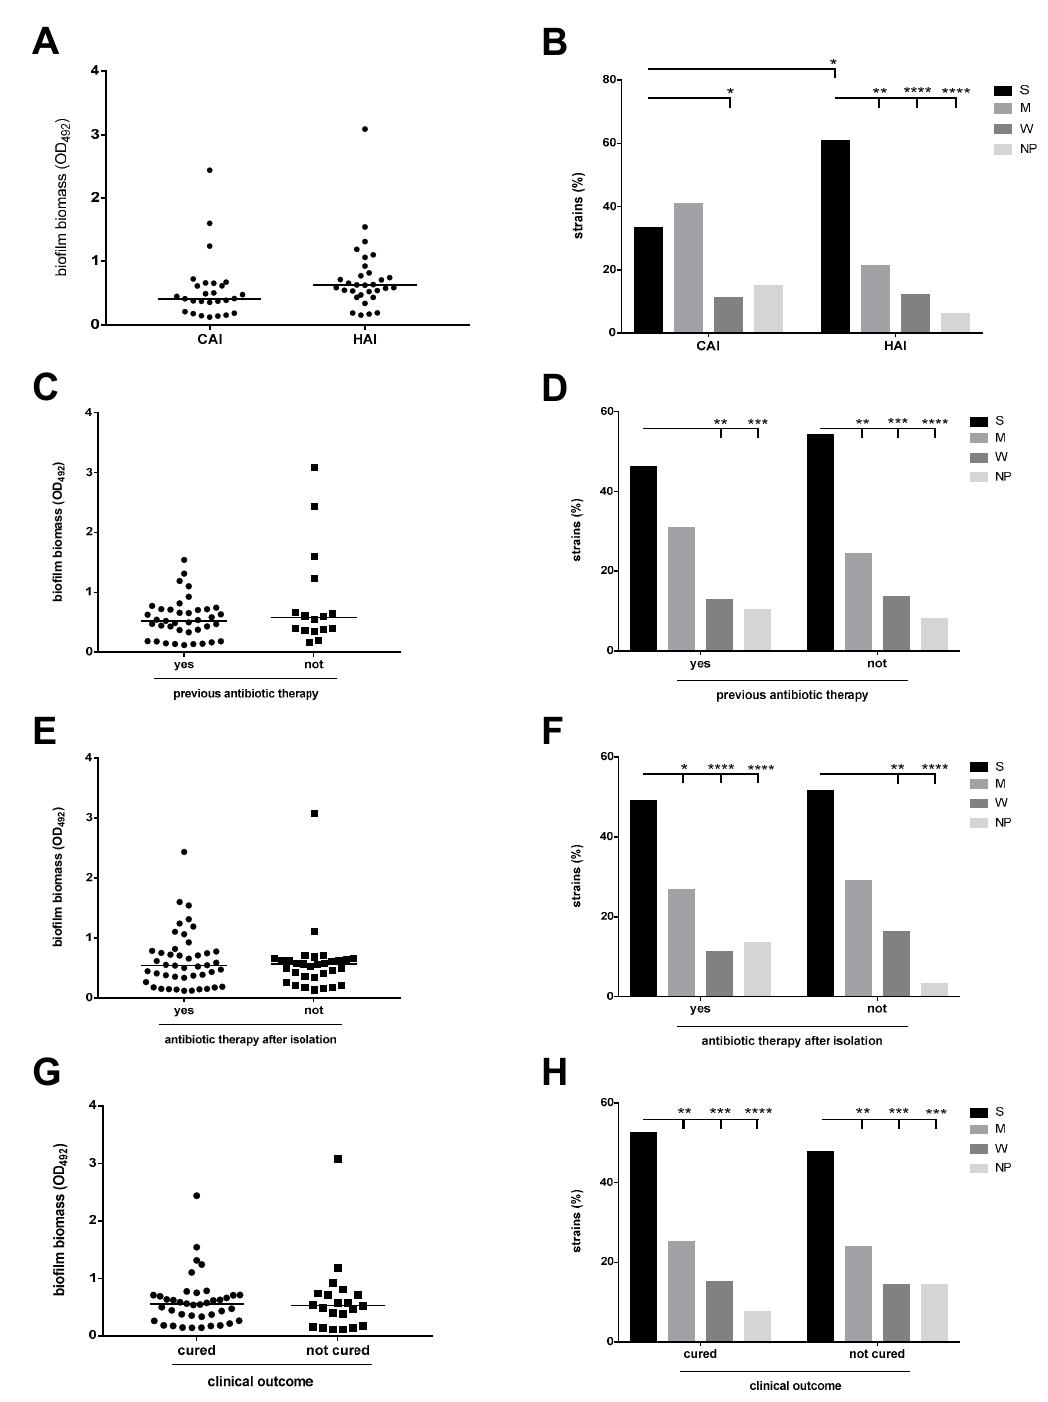
Figure 3. Biofilm formation by S. maltophilia strains: stratification on infection source, antibiotic therapy, and clinical outcome. Biofilm biomass formation was evaluated using a MTP assay. Biofilm values were stratified on: ( A , B ) infection source (community-acquired or hospital-acquired infection); ( C , D ) administration of antibiotic therapy before S. maltophilia isolation; ( E , F ) administration of antibiotic therapy after S. maltophilia isolation; and ( G , H ) clinical outcome after antibiotic therapy. ( A , C , E , G ) Each dot shows the mean OD 492 value, with the horizontal line showing the median value of each distribution. ( B , D , F , H ) Each strain was classified as: strong—(S), moderate—(M), weak—(W) or non-producer (NP) based on the biofilm biomass value and according to Stepanovi´c et al. [24]. * p < 0.05, ** p < 0.01, *** p < 0.001, and **** p < 0.0001, Fisher’s exact test.